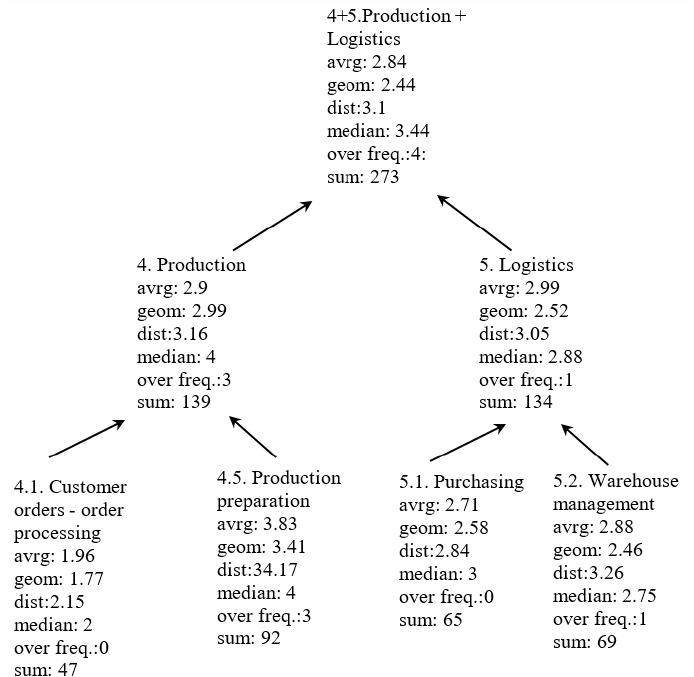
Figure 2. Results of multilevel aggregation.